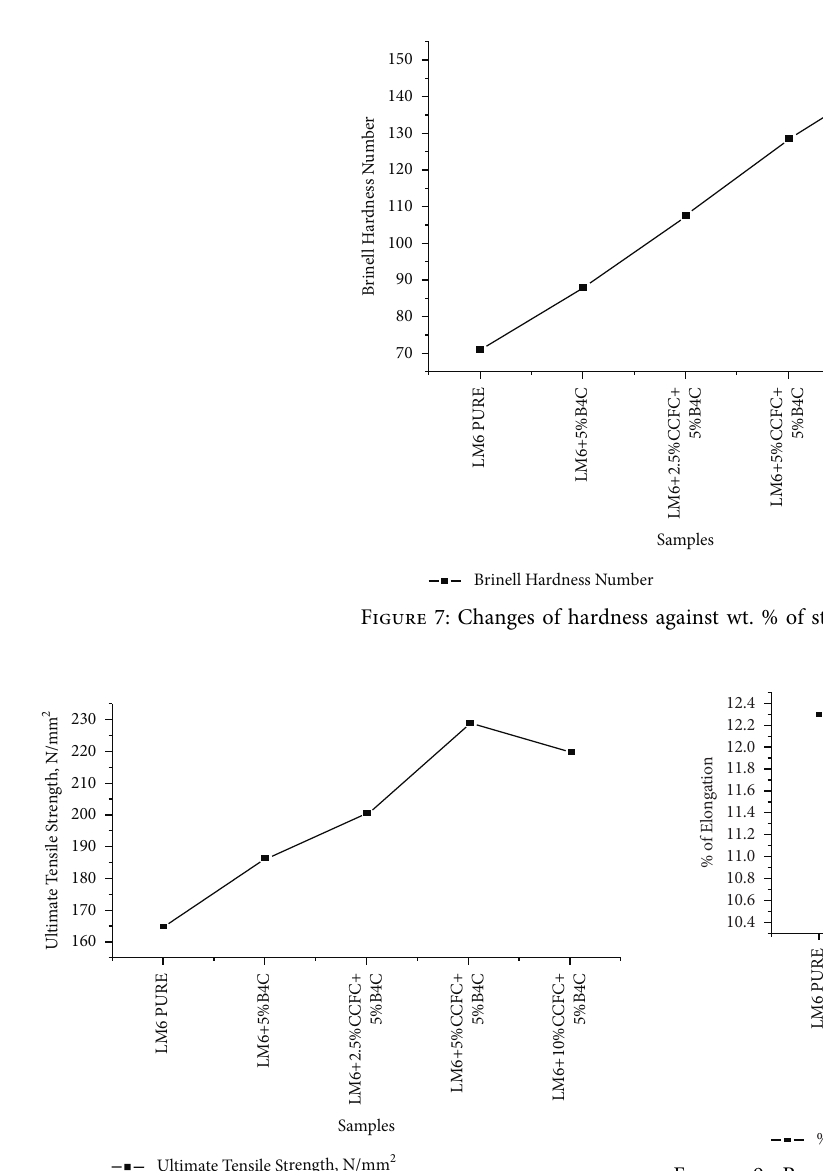
Figure 8: Extreme tensile strength of LM6 Al alloy hybrid composites.